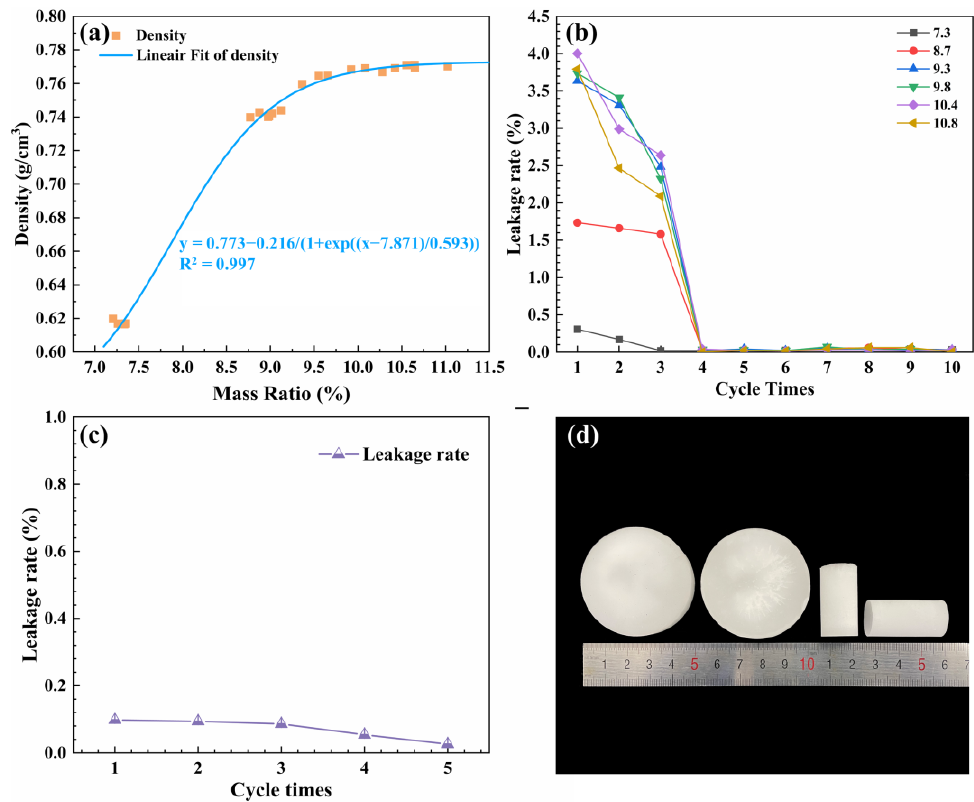
Figure 1. ( a ) The density versus the mass ratio, ( b ) the leakage rates at different heating–cooling cycles, ( c ) the leakage rates of the paraffin/MSA composites after three heating–cooling cycles and ( d ) photo of the samples .